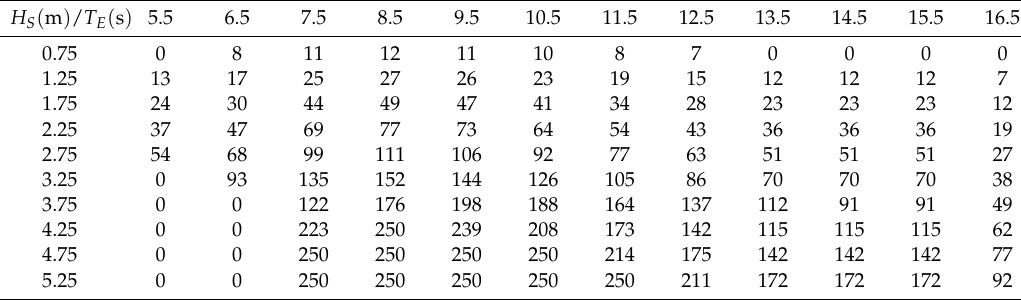
Table A2. Power matrix for WEC Aqua Buoy